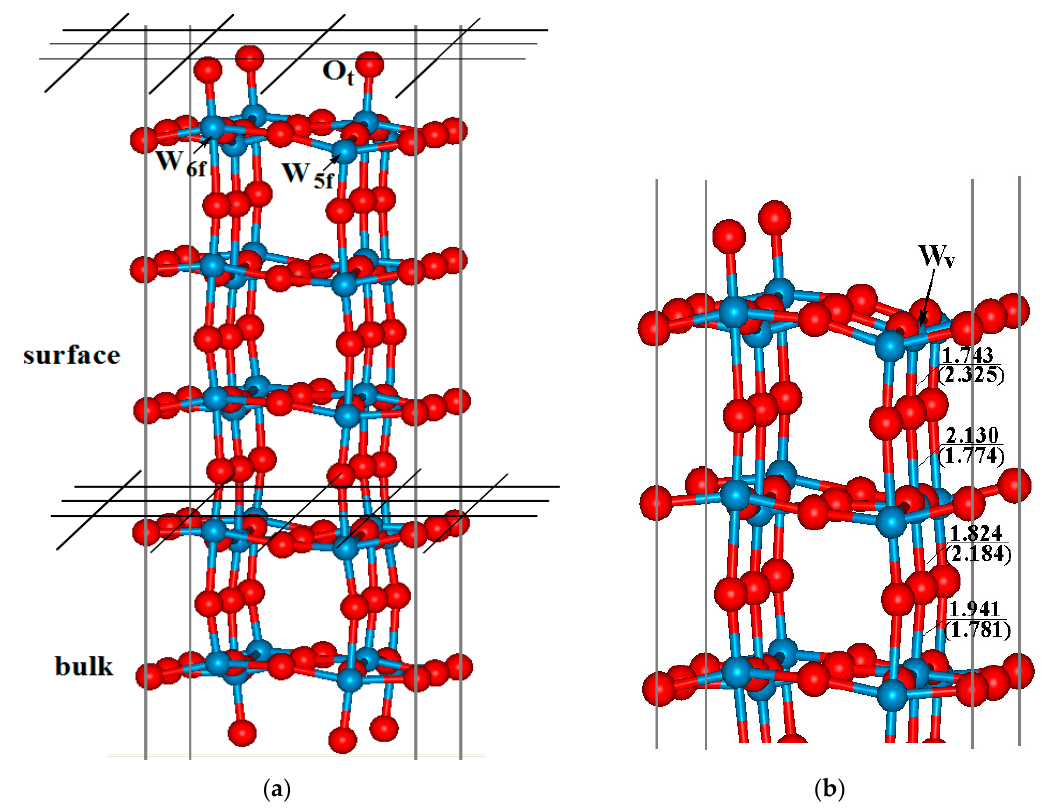
Figure 1. Configuration of ( a ) five-layer perfect WO 3 (001) surface and ( b ) defective WO 3 (001) surface with half of the top oxygen atoms missing. The blue and red balls stand for tungsten and oxygen atoms, respectively.